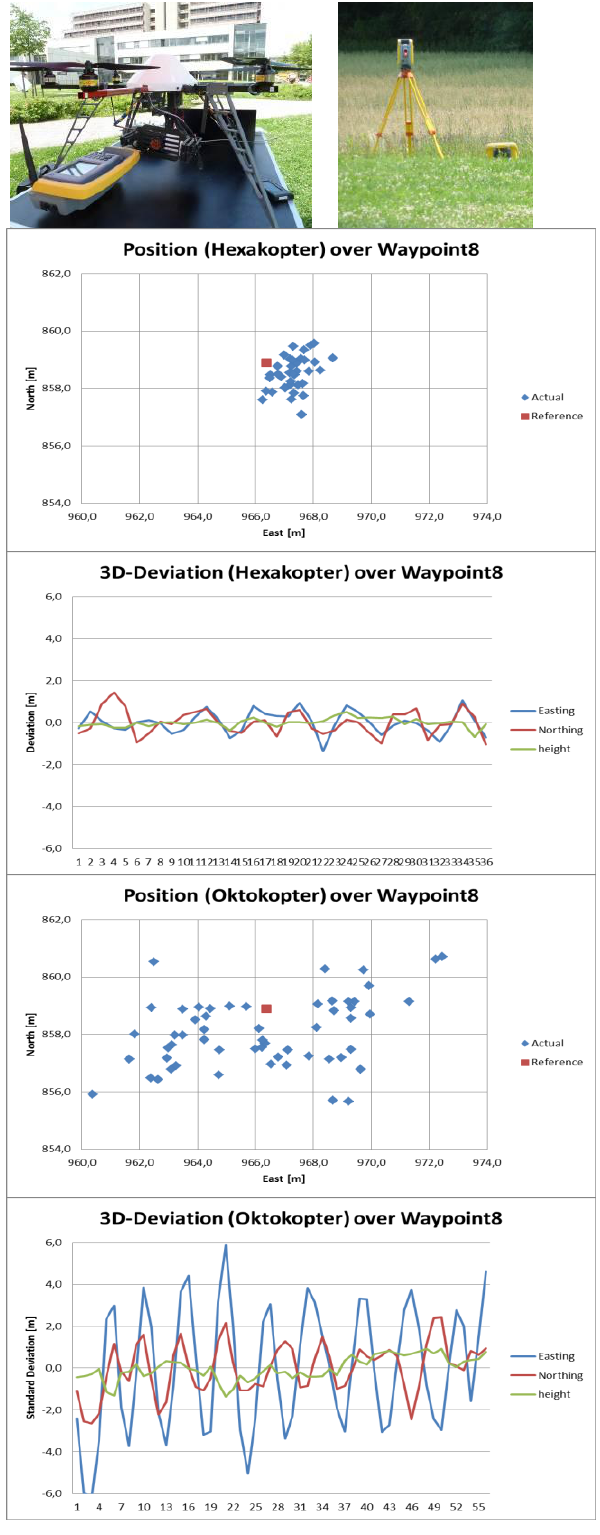
Figure 6. Copter-Tracking with tachymeter Trimble S6 The results offer a typical oscillation caused by the controlling of the vehicle over the waypoint by the flight control. The amplitudes accomplish an amount of up to 6 m (Oktokopter) and only 1.5 m with the Hexakopter. Because the flight and weather conditions were nearly the same the differences are